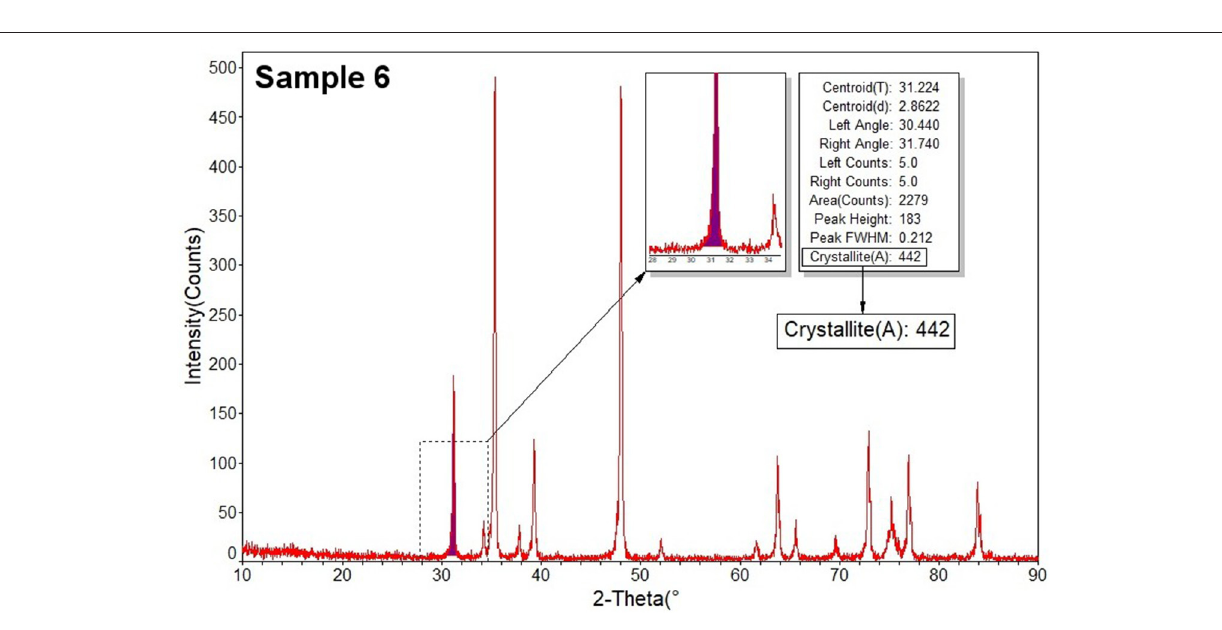
FIGURE 2 | XRD patterns of sample 6 with 6.0 wt.% Mo 2 C